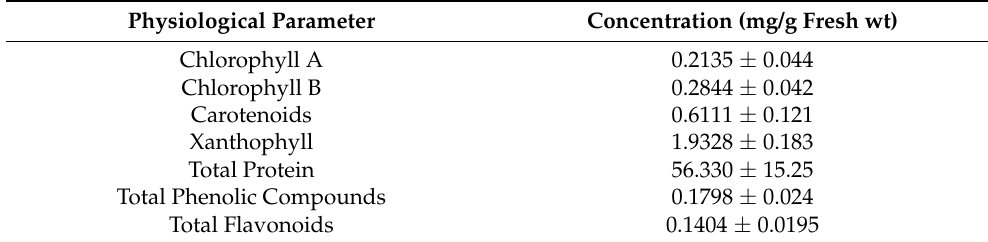
Table 2. Means of physiological parameters after four weeks of Zantedeschia grown on MS in vitro